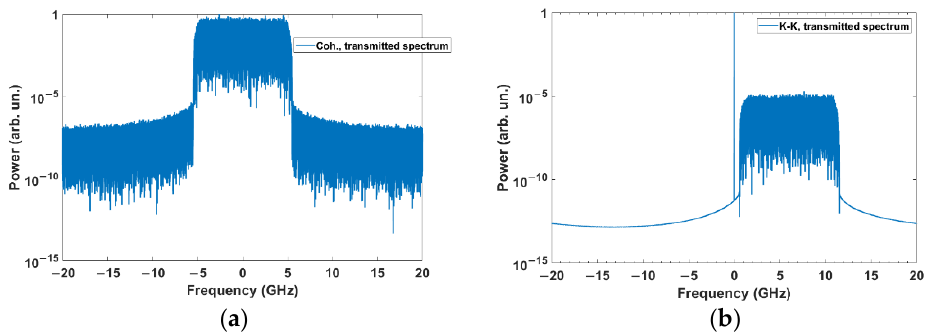
Figure 4. KK transceiver performance versus K -factor for satellite-to-satellite, downlink, and uplink communications.